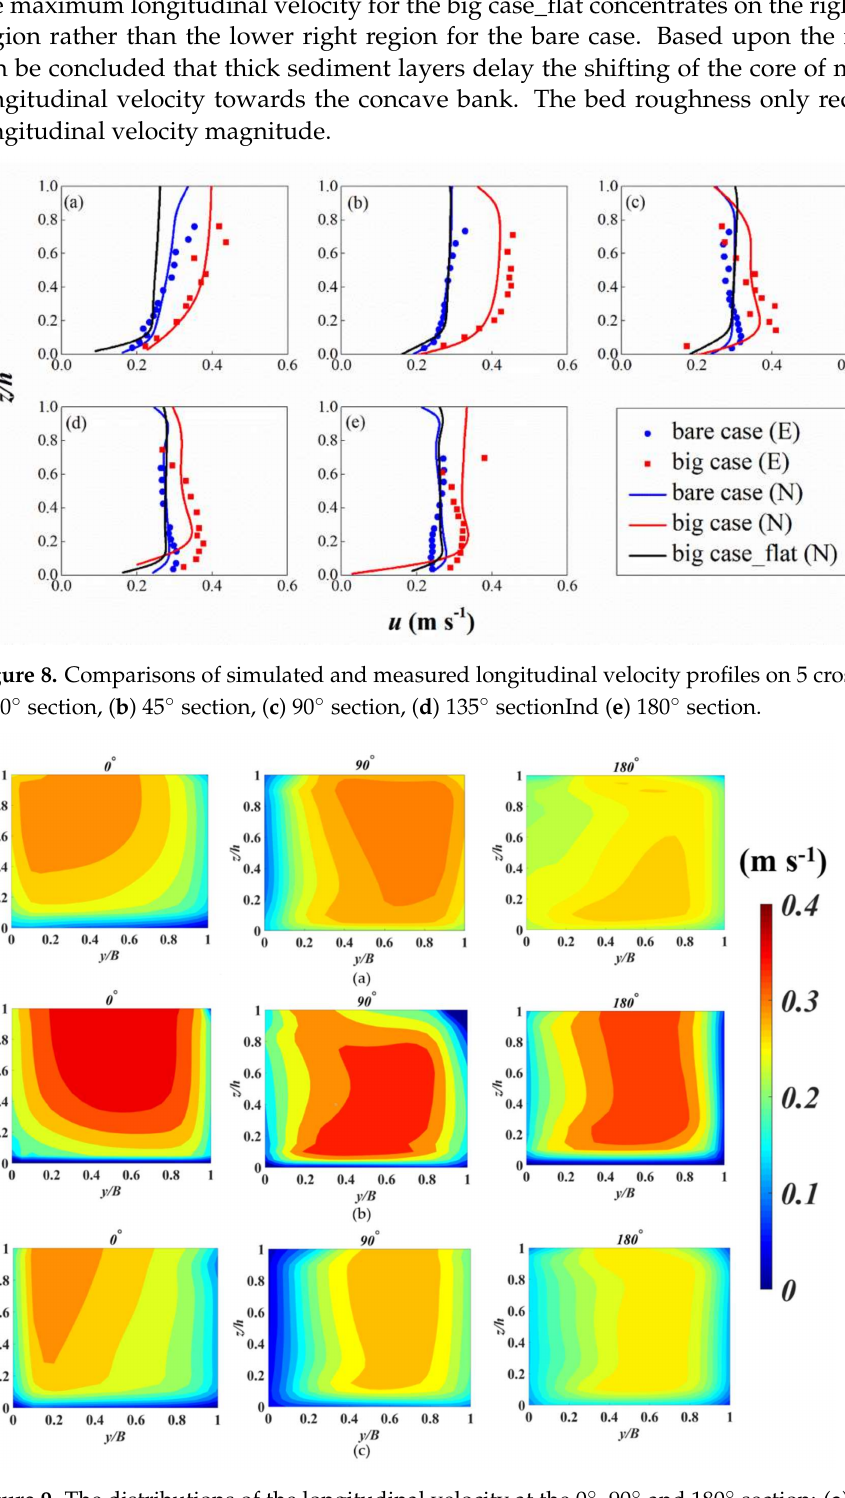
Figure 9. The distributions of the longitudinal velocity at the 0 ◦ , 90 ◦ and 180 ◦ section: ( a ) Bare case, ( b ) Big case, and ( c ) Big